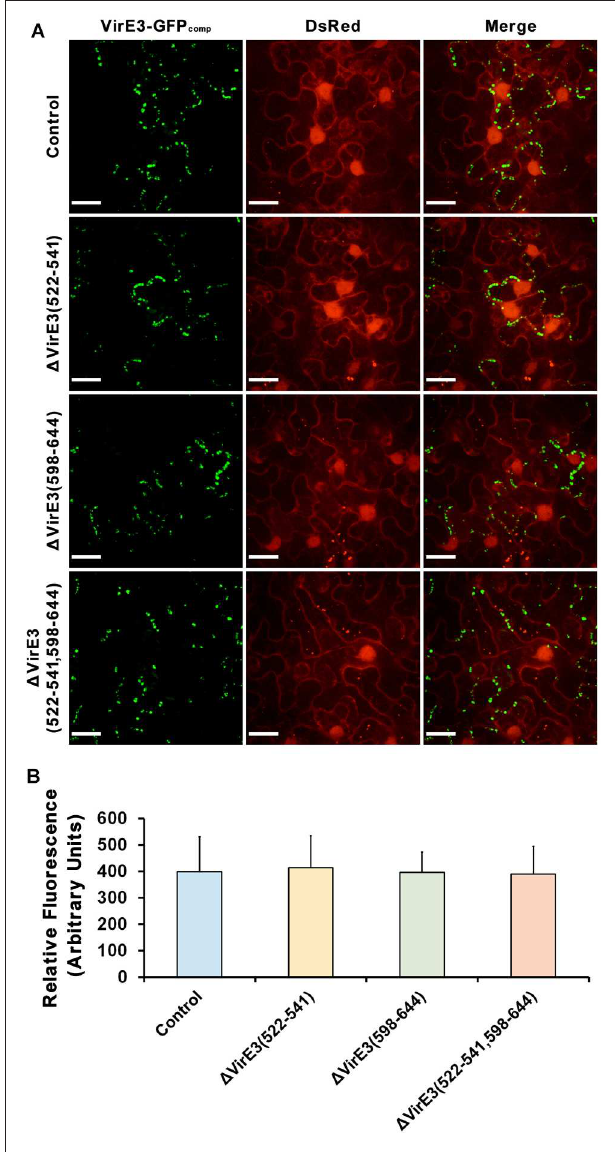
FIGURE 5 | Deletions of VirE2-interacting domains of VirE3 do not affect VirE3 accumulation at the host cell border. (A) N. benthamiana (Nb308A) leaves were infiltrated with A. tumefaciens EHA105 virE3::GFP11 (control), EHA105 virE3::GFP11 1 VirE3(522-541), EHA105 virE3::GFP11 1 VirE3(598-644) or EHA105 virE3::GFP11 1 VirE3(522-541,598-644). Scale bars, 20 µ m. (B) The fluorescence intensity of VirE3-GFP comp signals was measured in each image. Data are presented as the mean ± SD of n = 20 independent